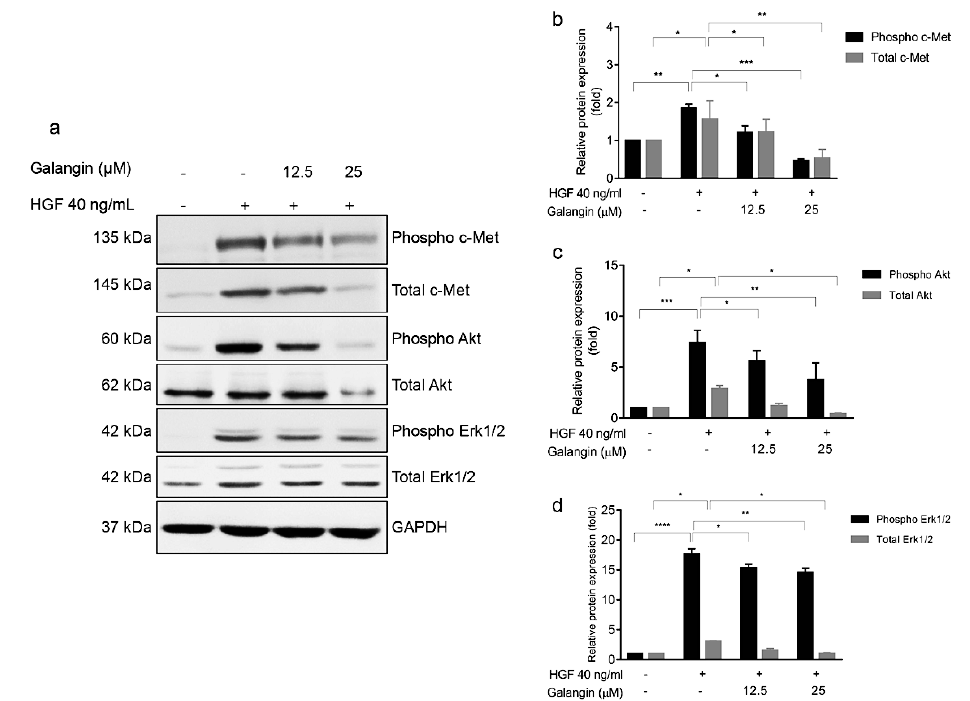
Figure 6. Galangin treatment with HGF-stimulated KKU-213 cells affects c-Met signaling. ( a ) Effect of Galangin on HGF-stimulated cell signaling by western blotting. Cells were analyzed for ( b ) phospho c-Met, total c-Met, ( c ) phospho Akt, total Akt, ( d ) phospho ERK1/2, and total ERK1/2 expression by Western blotting. GAPDH was used as loading control to normalize the amount of protein in each experiment conditions. Data are the mean ± SEM from three independent experiments, * p ≤ 0.05, ** p ≤ 0.01, *** p ≤ 0.001, **** p ≤ 0.0001 compared with the HGF